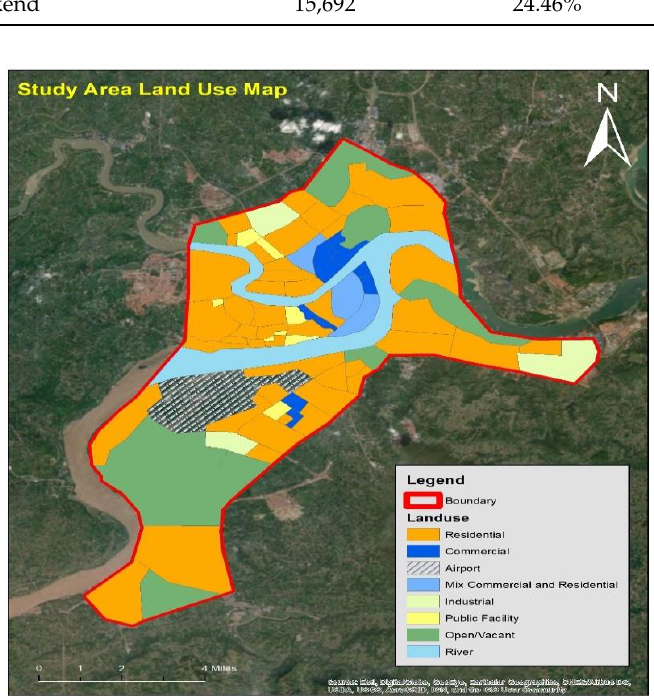
Figure 2. Land use map of study area .